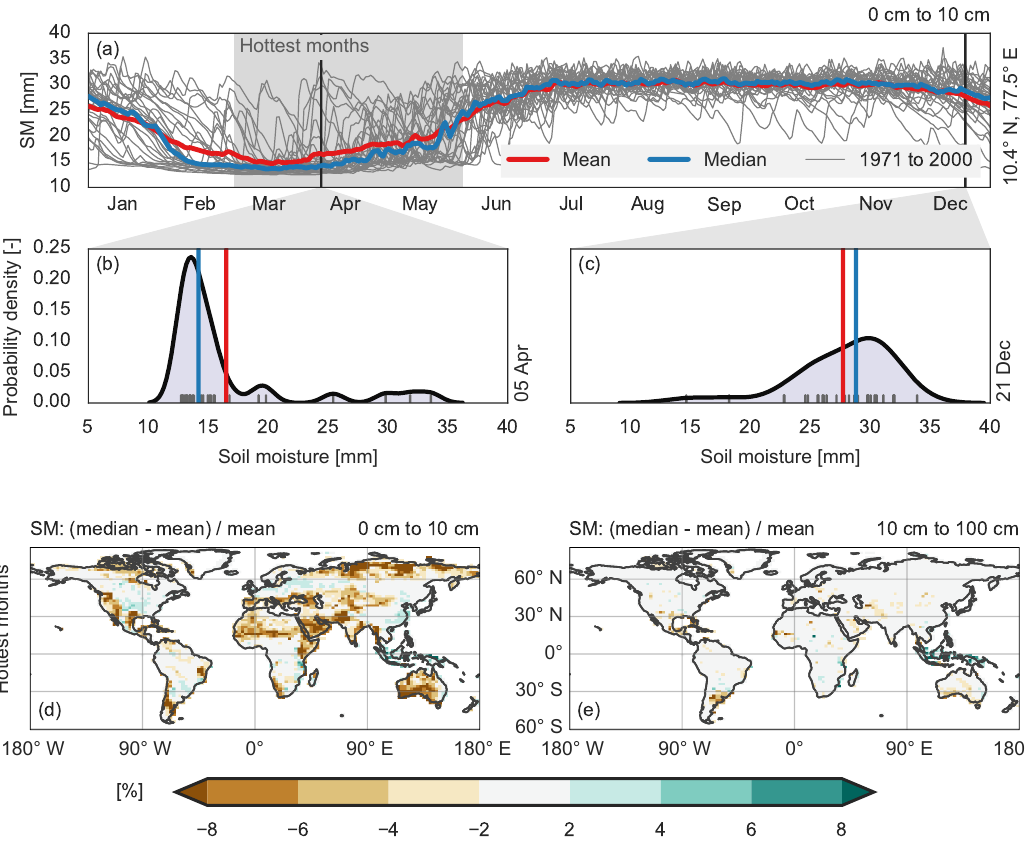
Figure 2. Difference between mean and median SM. (a) Seasonal cycle of total SM in the top 10 cm for an example grid point in India (10.4 ◦ N, 77.5 ◦ E) as simulated by CLM for the climatological period (1971 to 2000). Shown are the individual years (grey lines), and their mean (red) and median (blue). Light grey background shows the 3 consecutive hottest months at this grid point and vertical black lines the 2 days depicted in (b) and (c) , respectively. (b) and (c) Kernel density estimate of the SM distribution (thick black line), including the individual years (thin grey lines) and the mean (red) and median (blue) SM values for the 5 April (b) and 21 December (c) . (d) and (e) Relative difference in the SM climatology between median and mean for the hottest months of the year in the surface layer (0 to 10cm, d ) and in 10 to 100cm depth (e)